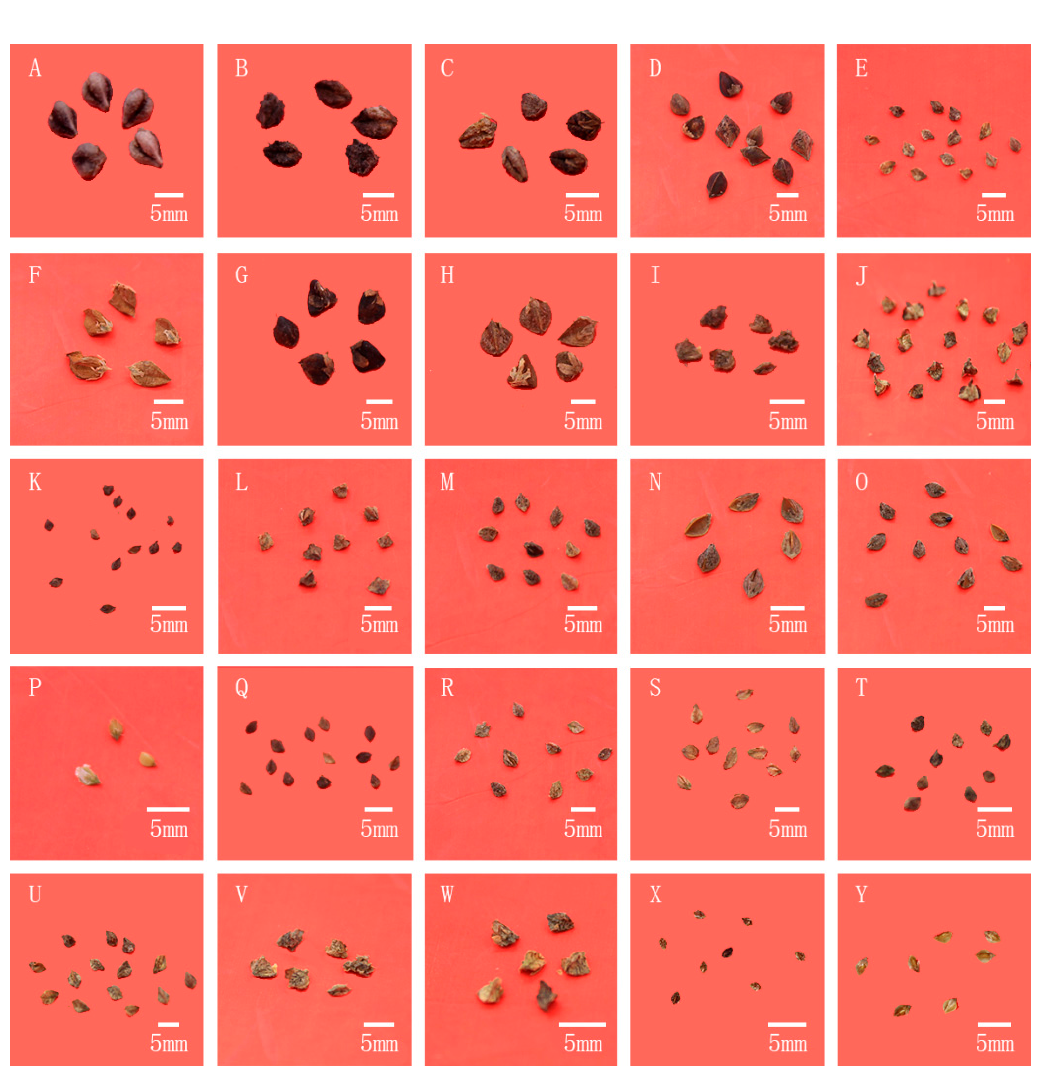
Figure 1. Fruit morphology of different species in Fagopyrum . Note: The species names of fruits ( A – Y ) as follows: F. tataricum , F. tataricum (sichuan), F. tataricum (yunnan), F. esculentum cv. T12 , F. esculentum ssp. ancestralis , F. megaspartanum , F.cymosum (sichuan), F.cymosum (yunnan), F. gracilipes var. odontopterum-R , F. luojishanense , F. jinshaense , F. longzhousahnense , F. rubifolium , F. qiangcai , F. callianthum , F. wenchuanense , F. capillatum , F. pugense , F. urophyllum , F. leptopodum , F. gracilipes , F. crispatifolium , F. gracilipes var. odontopterum , F. lineare , F. macrocarpum